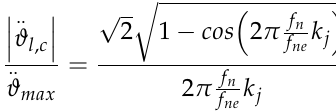
Figure 17. ( a ) Motor and load acceleration when t j = dec ( f n , e t a ) / f n , e ; ( b ) sensitivity curve when t j = dec ( f n , e t a ) / f n , e f .